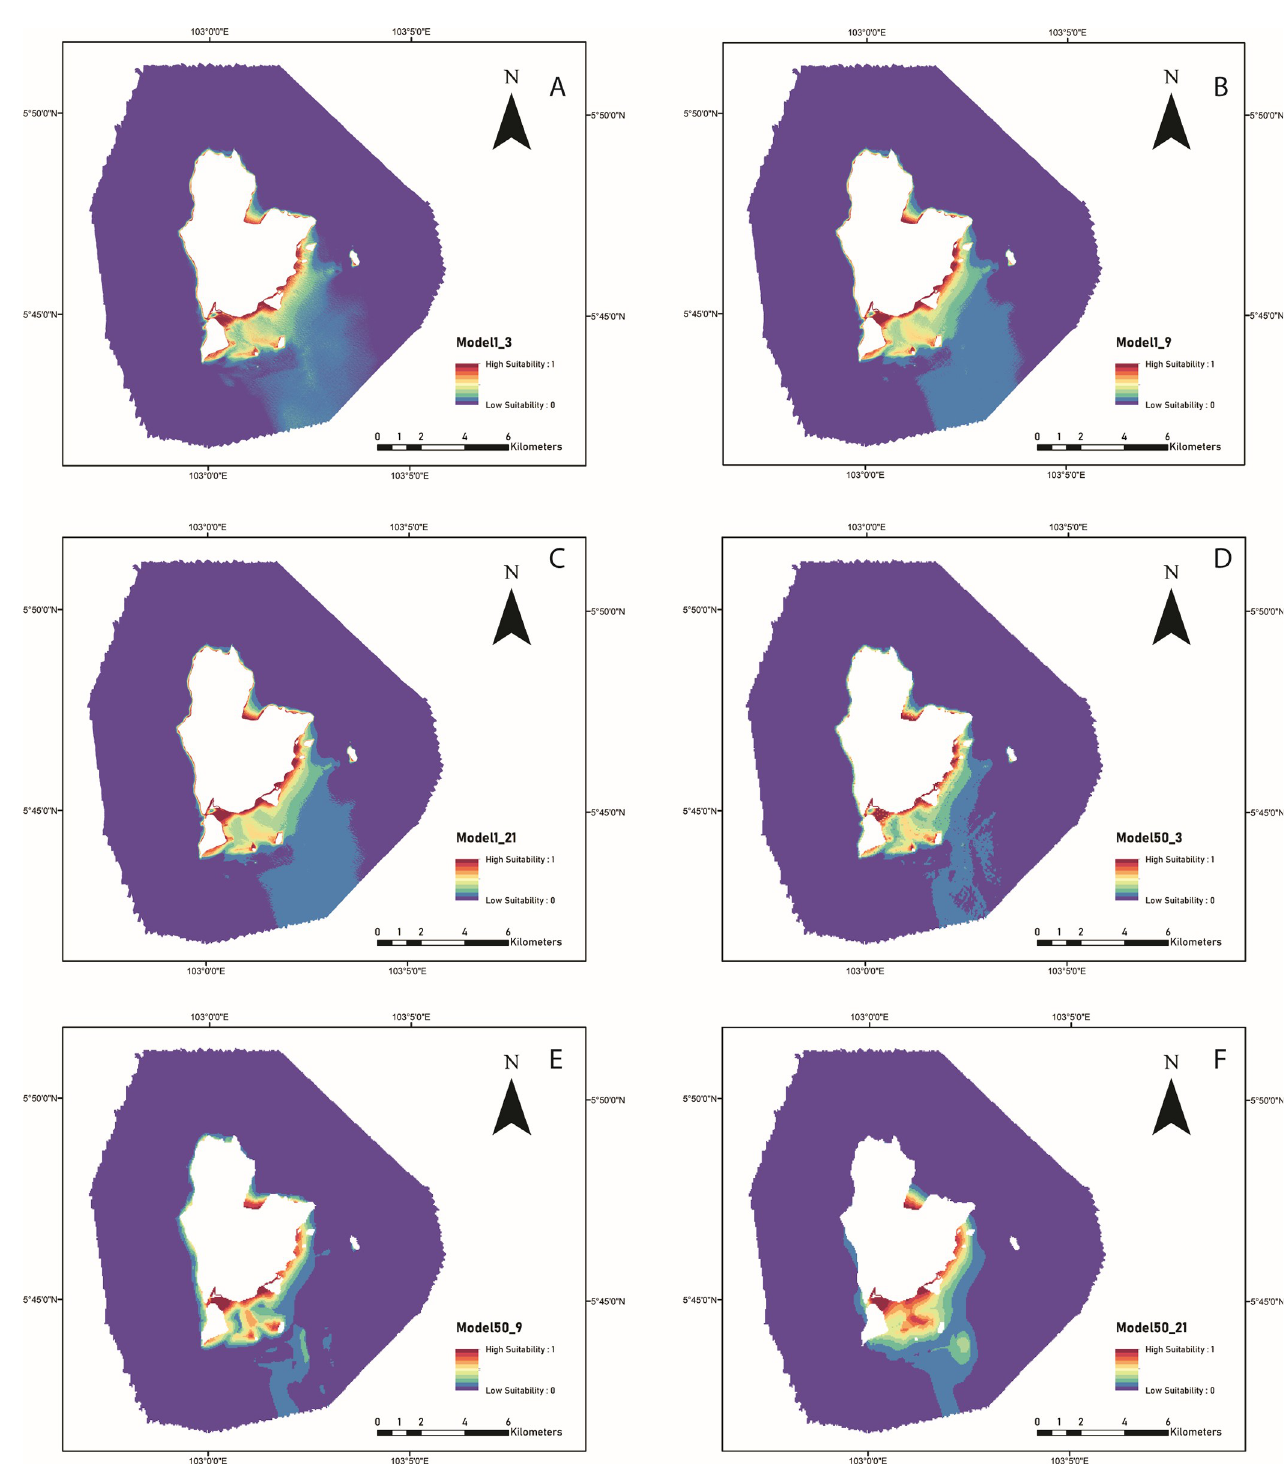
Fig 5. Model predictions on the suitability of the seagrass habitat across the MBES surveyed area. These models were produced using predictors derived from three analysis window sizes (n = 3, 9, and 21) and gridded at 1 m and 50 m; (A) 1 m (n = 3), (B) 1 m (n = 9), (C) 1 m (n = 21), (D) 50 m (n = 3), (E) 50 m (n = 9), and (F) 50 m (n = 21). The suitability index ranges from 1 (high suitability) to 0 (low suitability).